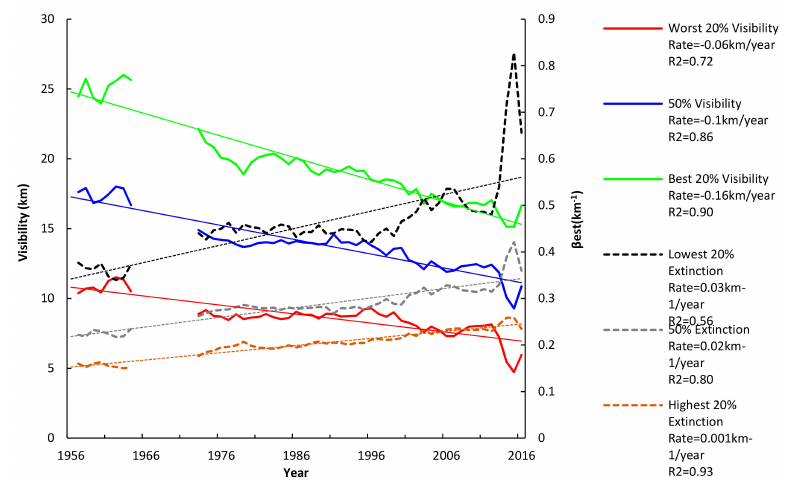
Figure 5. Lowest 20% and 50%, and the highest 20% average regional atmospheric visibility as well as extinction trends for the average of PCCs in China. Dashed lines refer to the curves of linear regression of the corresponding lines of trends.